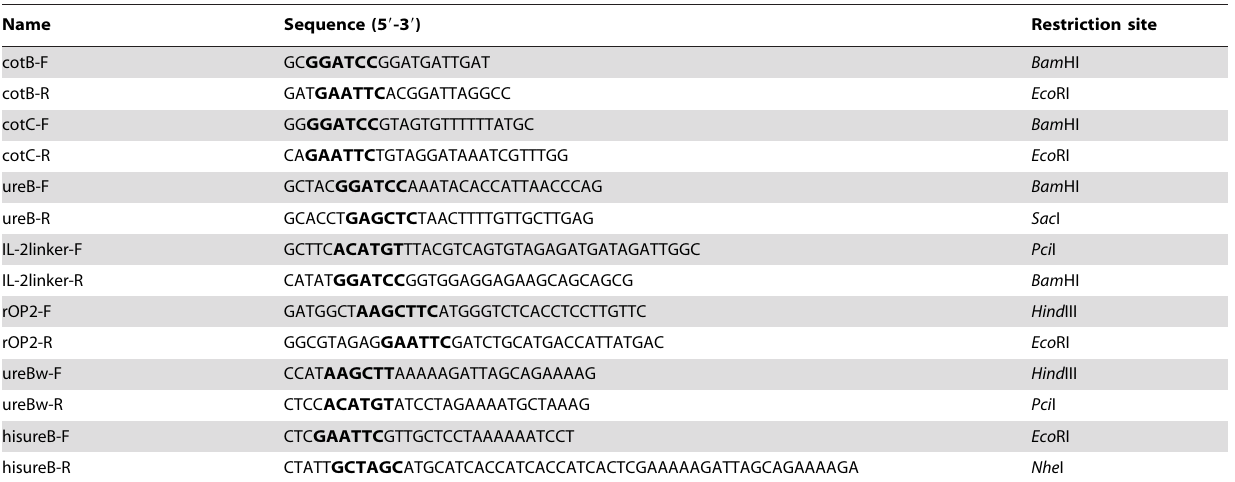
Table 2. Oligonucleotide